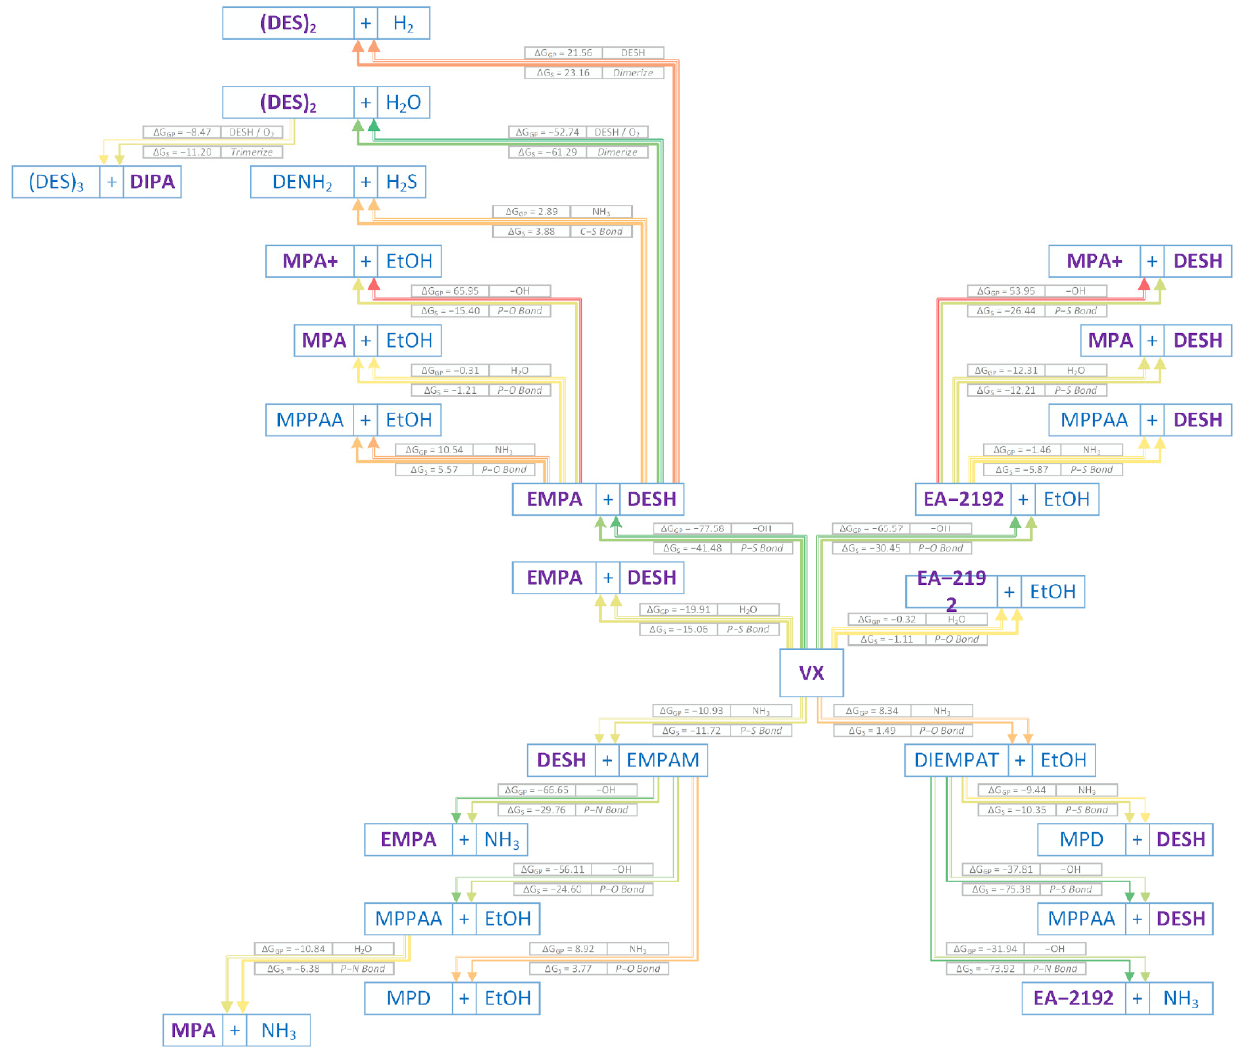
Figure 5. Reaction pathways for the complete degradation of VX in an alkaline environment. Reaction-free energies were obtained from HF calculations in gas phase (GP) and solvent (water, S) environments. Compounds in purple indicate species that have been detected experimentally. Reaction arrows are colored according to the reaction free energy values (green: Favorable, yellow: Slightly favorable or unfavorable, red: Unfavorable).